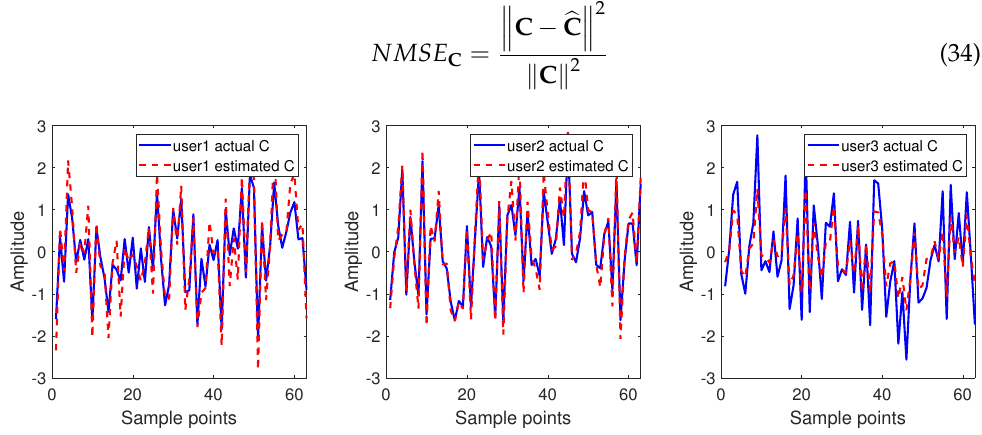
Figure 3. Estimation of spreading